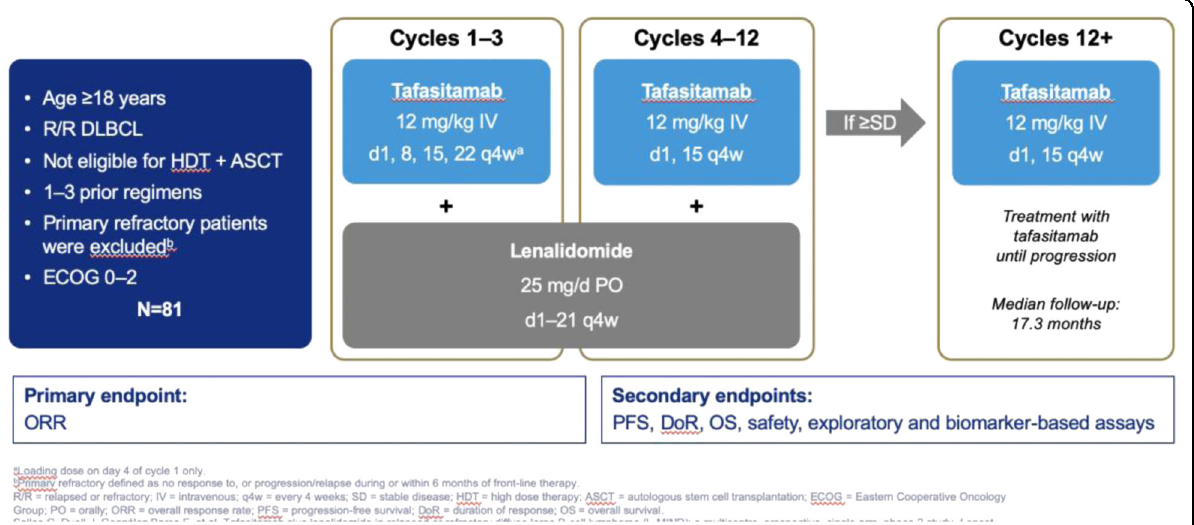
Fig. 2 Schema of the L-MIND regimen. Patients receive the combination of tafasitamab and lenalidomide for 12 cycles, and those with at least stable disease can continue on single agent tafasitamab until disease progression or